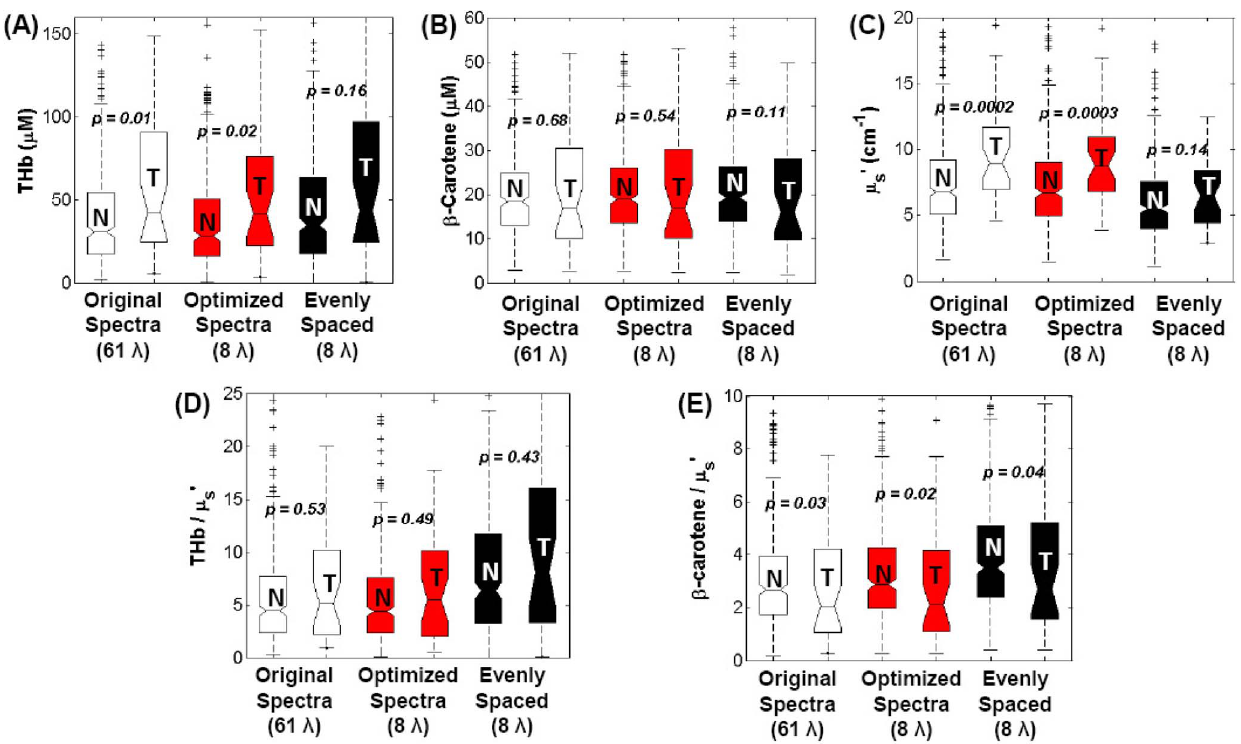
Figure 8. Comparison of Monte Carlo extractions of normal and cancerous tissue parameters. Comparison of the MC extractions of [THb], [ b c], , m s ’ . , [THb]/ , m s ’ . , and [ b c]/ , m s ’ . in adipose, fibroglandular, and malignant tissue types using full spectrum versus the optimized reduced wavelength spectrum and evenly spaced spectrum with 8 wavelengths. Sample sizes are Normal (N)=344, and Tumor (T)=38.